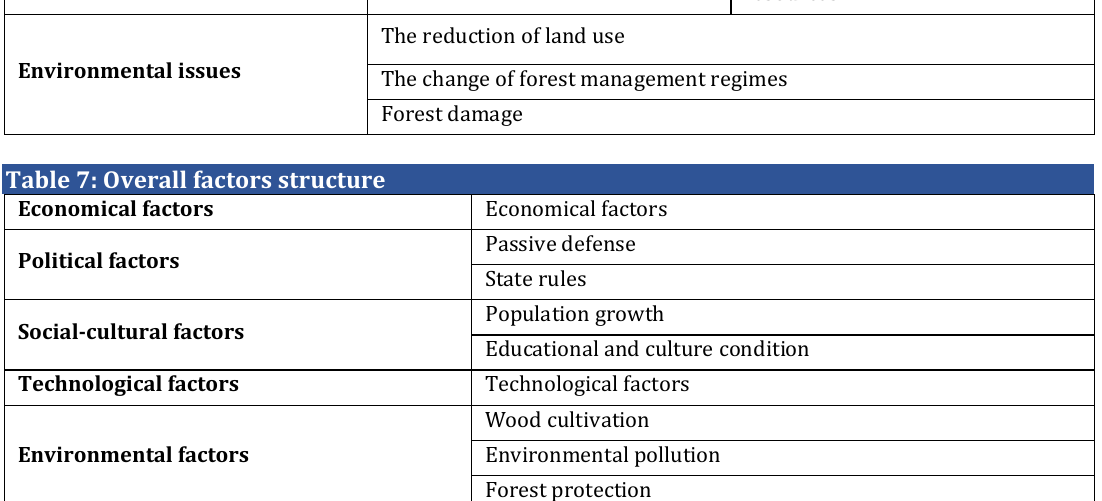
Table 7: Overall factors